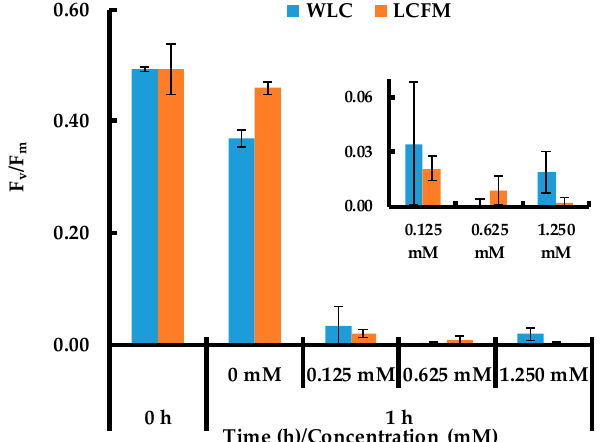
Figure 6. Quantum efficiency of C. reinhardtii cells before (0 h) and after (1 h) the addition of AgNO 3 to WLC and LCFM at different concentrations (the inset magnifies the ~0 F v /F m columns by using shorter y-axis scale).